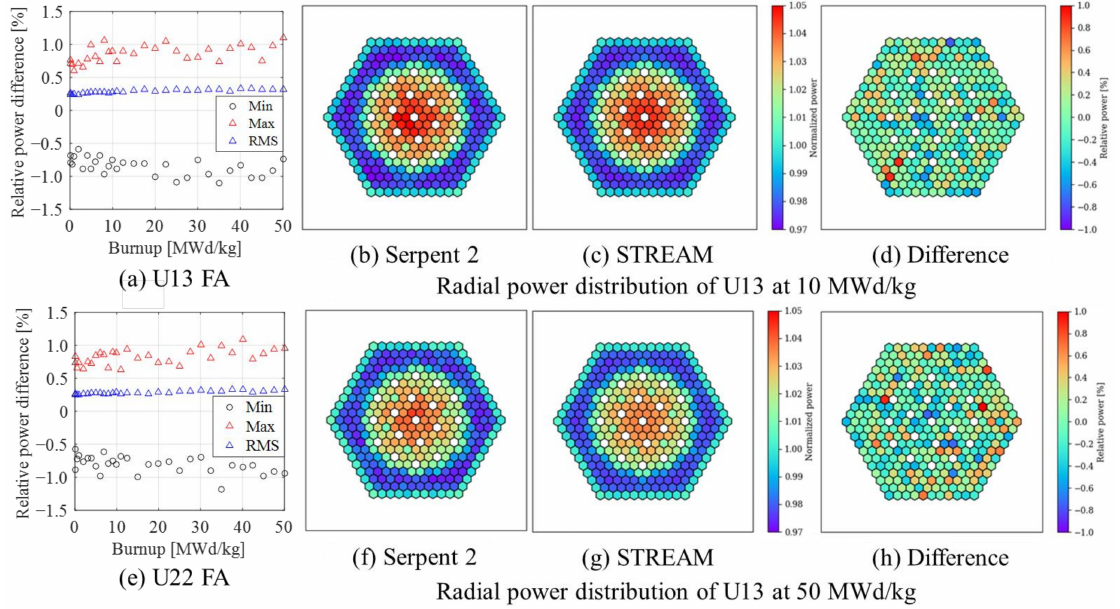
Figure 14. Comparison of radial power